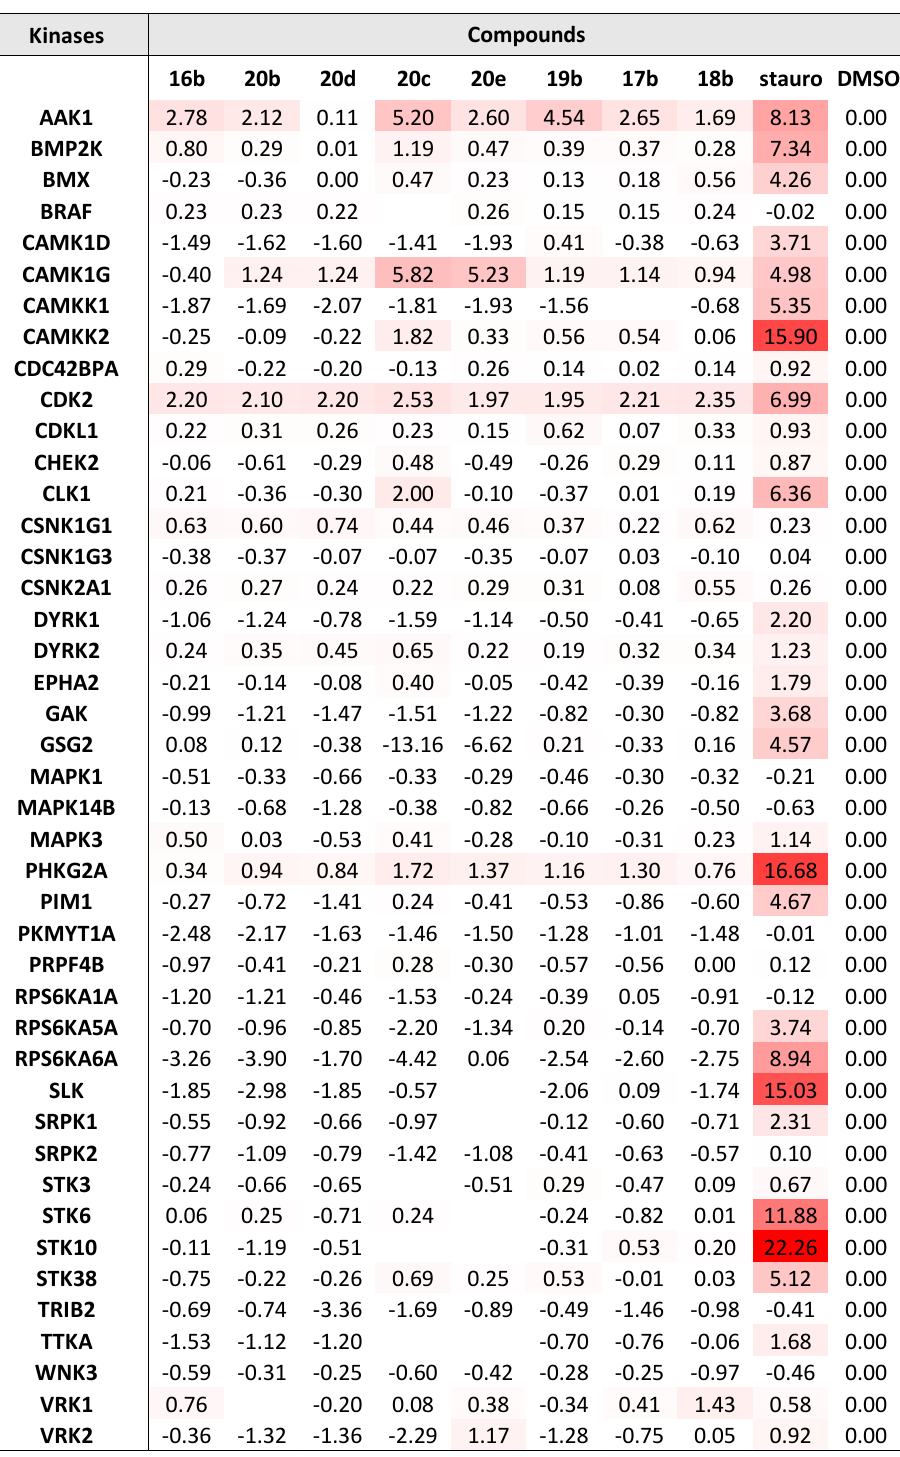
Figure 5. Results obtained from a kinase panel using differential scanning fluorimetry (DSF).